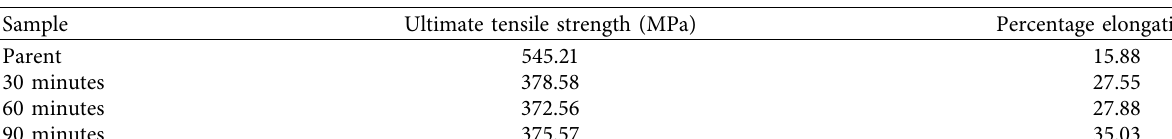
Table 4: Tensile results for all periods and